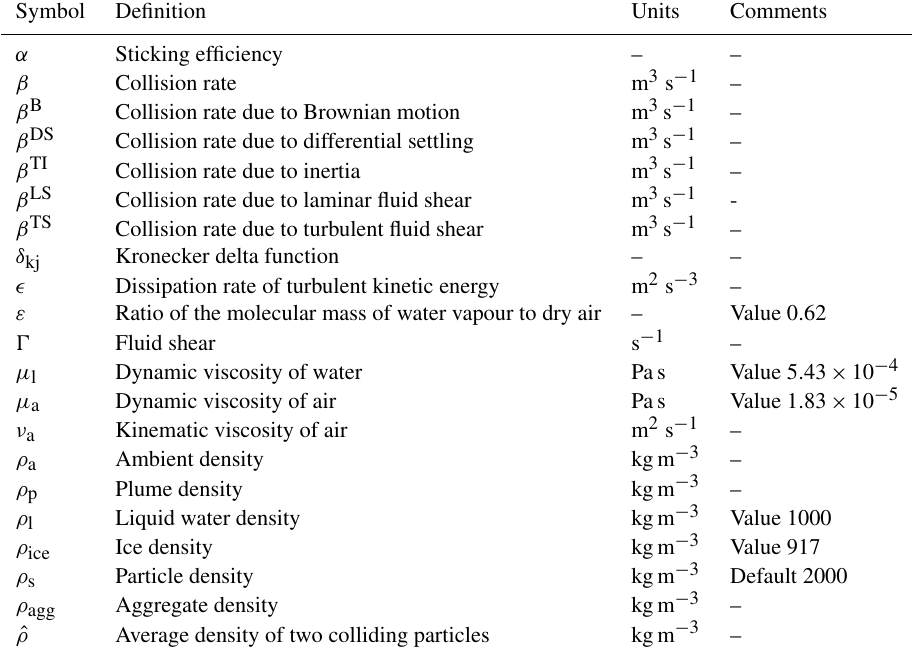
Table 2. List of Greek symbols.